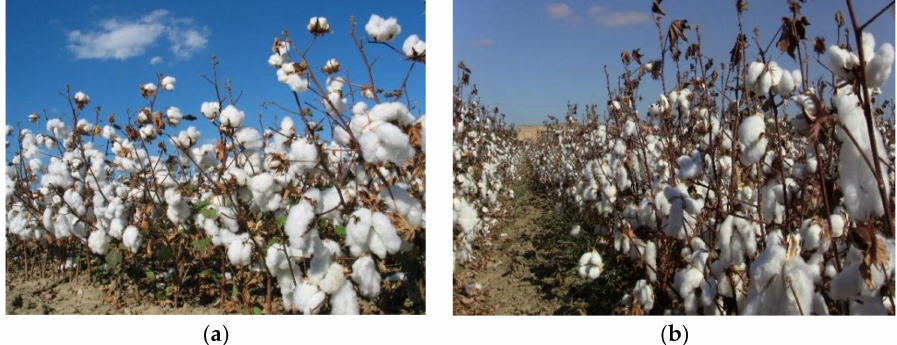
Figure 1. The two cultivars of Gossypium hirsutum L. used in second year trials: ( a ) Elsa; ( b )